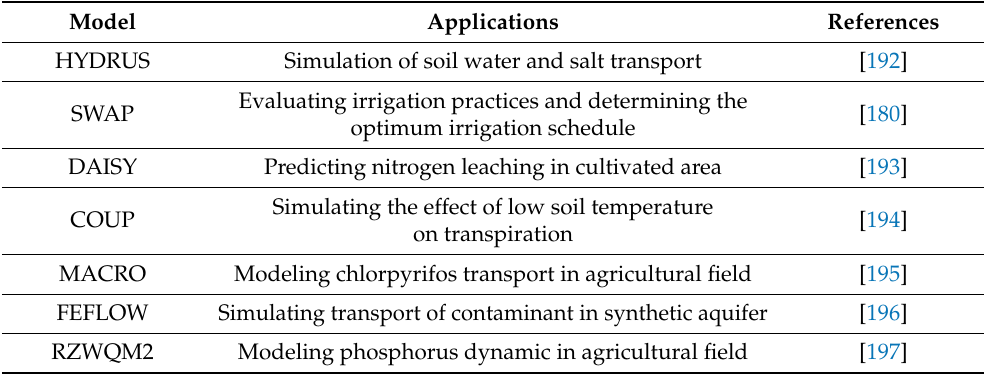
Table 3. Different applications of numerical models that solve the Richards and convection– dispersion